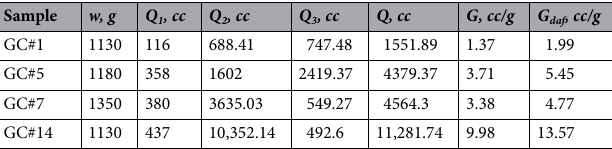
Table 3. Gas content of the coal